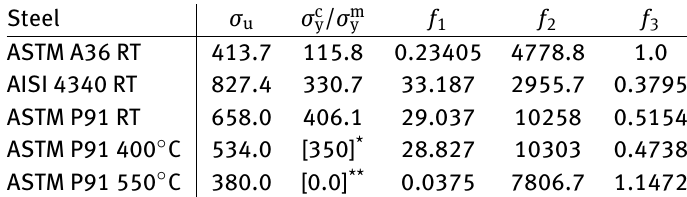
Table 3: Material parameters of the S-N curves for ASTM A36, AISI 4340 and ASTM P91 steels.